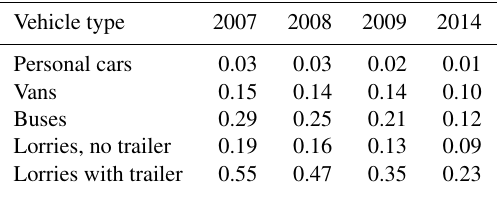
Table 4. Vehicular exhaust particulate matter emission factors (gkm − 1 per vehicle) for four years based on the LIPASTO emis- sion modelling